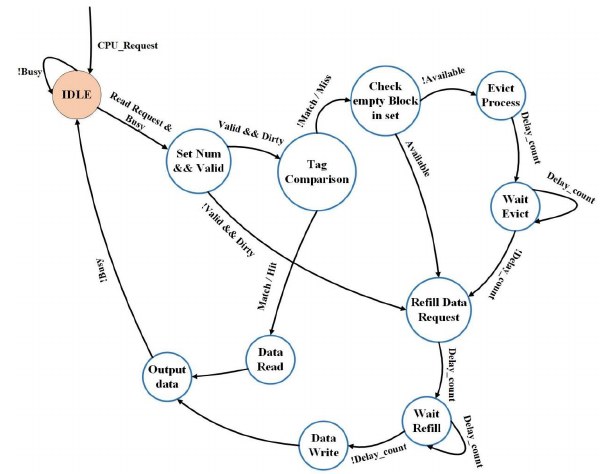
Figure 13. FSM of set-associative cache